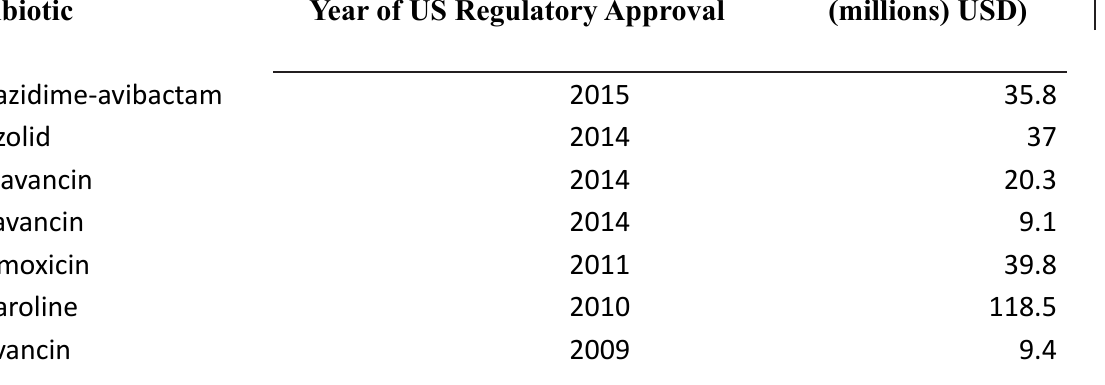
Table 2. Sales of recently marketed Antibiotics [ 74